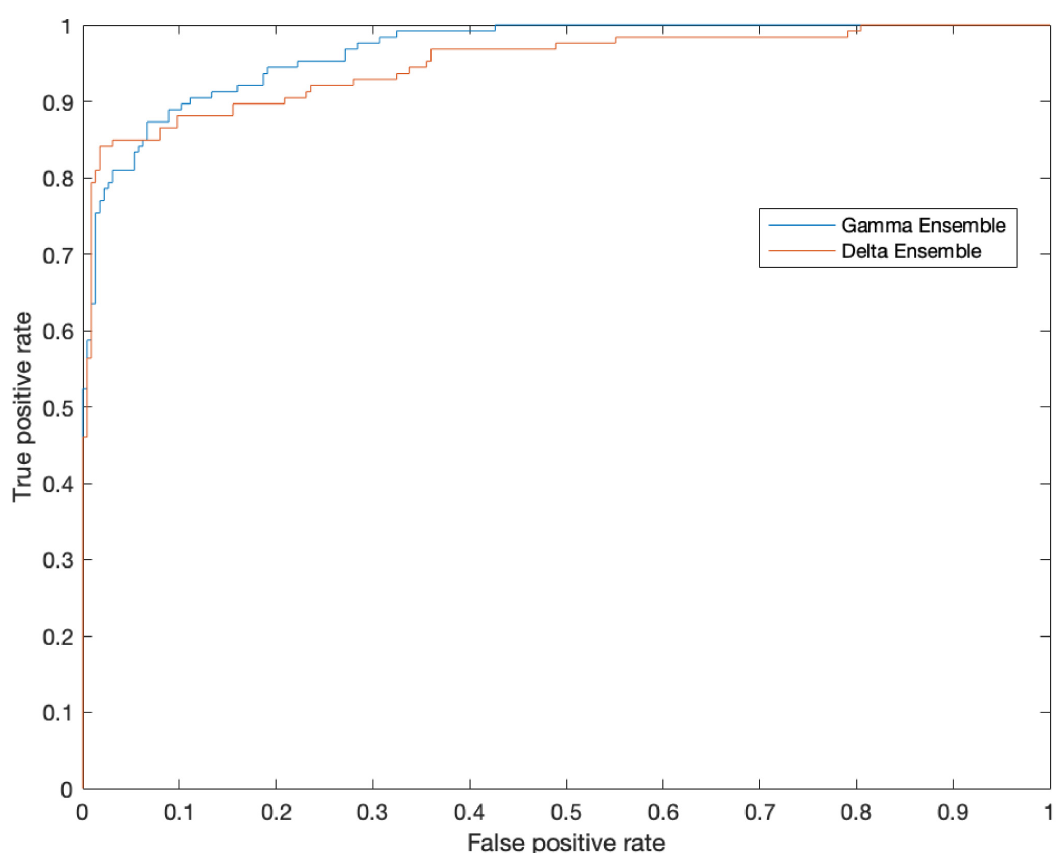
Fig 7. The Receiver Operating Characteristic (ROC) curves demonstrating the performance of Gamma and Delta Ensemble. The area under the curve is 0.9654 in the Gamma Ensemble and 0.9489 in the Delta ensemble.